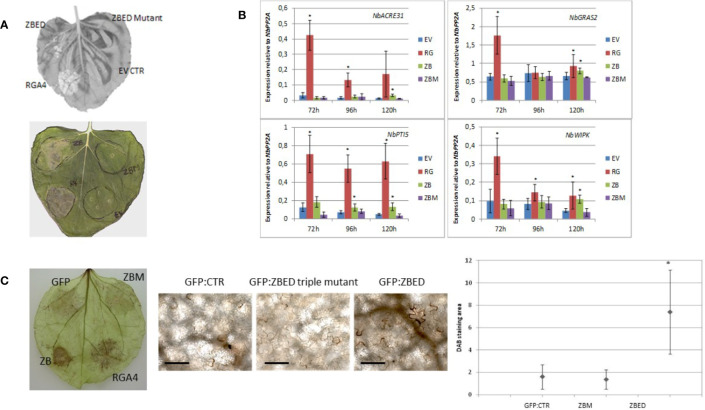
ZBED phenotypes related to basal immunity in N. benthamiana. (A) Transient expression of ZBED in N. benthamiana induces cell death. Transient expression of ZBED caused cell death four to five days after infiltration. ZBED mutants (ZBM) or GFP empty vector (EV) did not cause cell death. Positive control autoactive rice resistance gene RGA4 (R4-RGA4). (B) ZBED induces PAMP Triggered Immunity (PTI) in N. benthamiana as measured by RT-qPCR with four different PTI markers: NbACRE31, NbGRAS2, NbPTI5, and NbWIPK. ZBED triple mutant (ZBM) behaved like the GFP empty vector (EV) negative control at all time points and with all markers. Positive control autoactive rice resistance gene RGA4 (RG) (T-test *p < 0.05). (C) ZBED induced reactive oxygen species (ROS) measured with DAB staining, while ZBED mutant (ZBM) and GFP empty vector (EV) control did not. Quantification was done using EBImage (Pau et al., 2010; T-test *p < 0.05); scale bar is 100 µm.